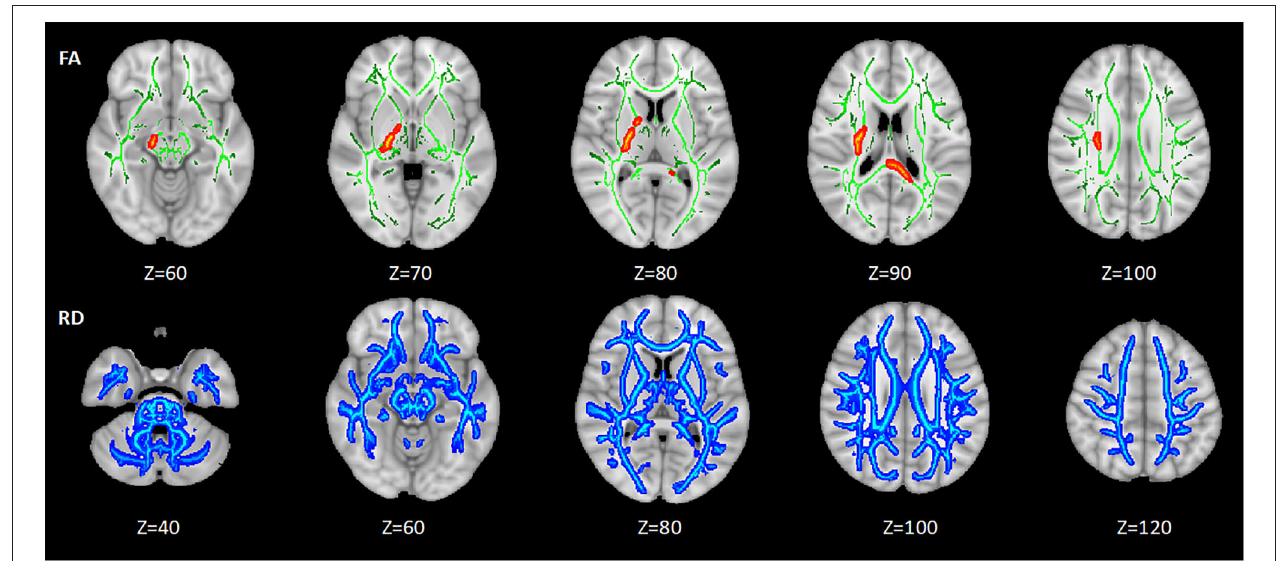
FIGURE 1 | The differences of DTI measures among the three groups. Areas in red and blue represent brain regions with significant difference in FA and RD (FWE-corrected p < 0.05). Green represents mean white matter skeleton of all subjects. The number below each brain image indicates the Z coordinate in the Montreal Neurological Institute (MNI) space.